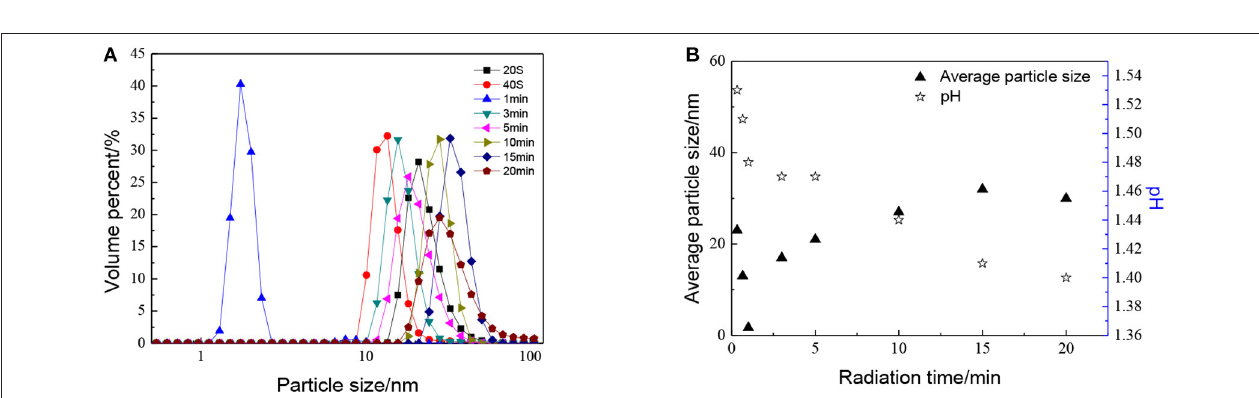
FIGURE 5 | Effect of radiation time on (A) particle size distributions and (B) average particle size and pH of ZrO 2 sols at an ultrasonic power of 90% and when the molar ratio of precursor to precipitant is 1:1.